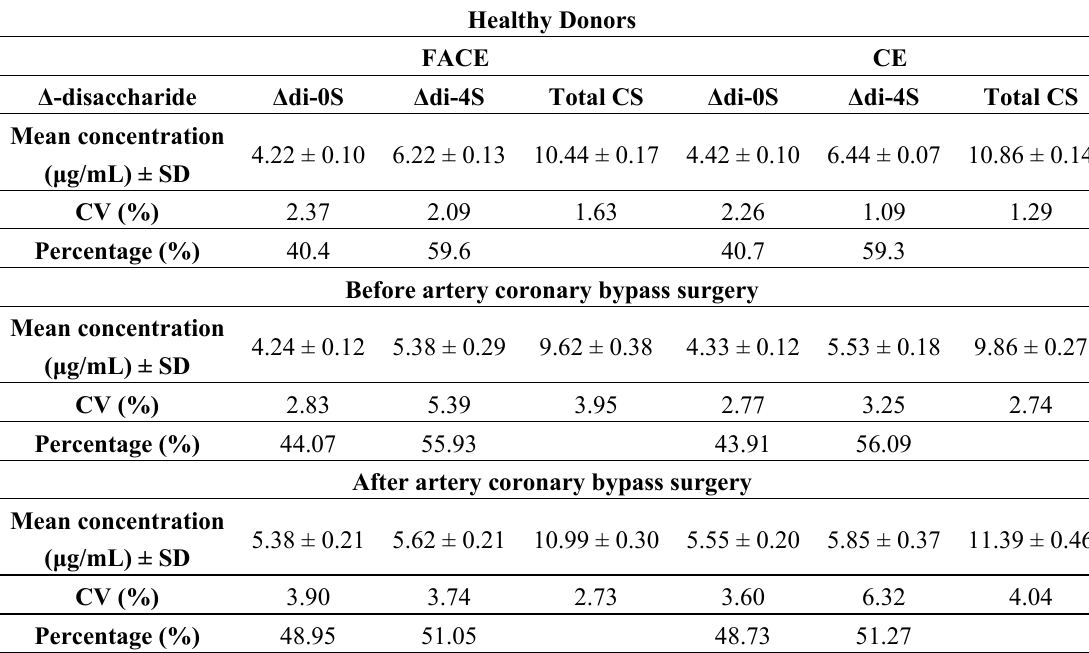
Table 1. Comparative data of CS composition and average concentrations in the blood serum of healthy donors ( n = 10) and patients with CHD ( n = 6) before and after coronary artery bypass surgery after analysis with FACE and CE analytical